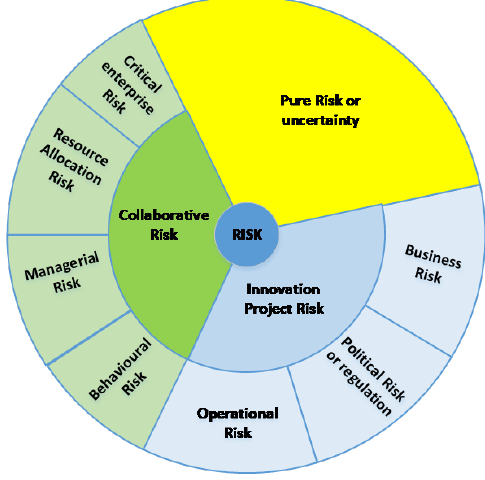
Figure 1: Wheel of innovation risks in a collaborative